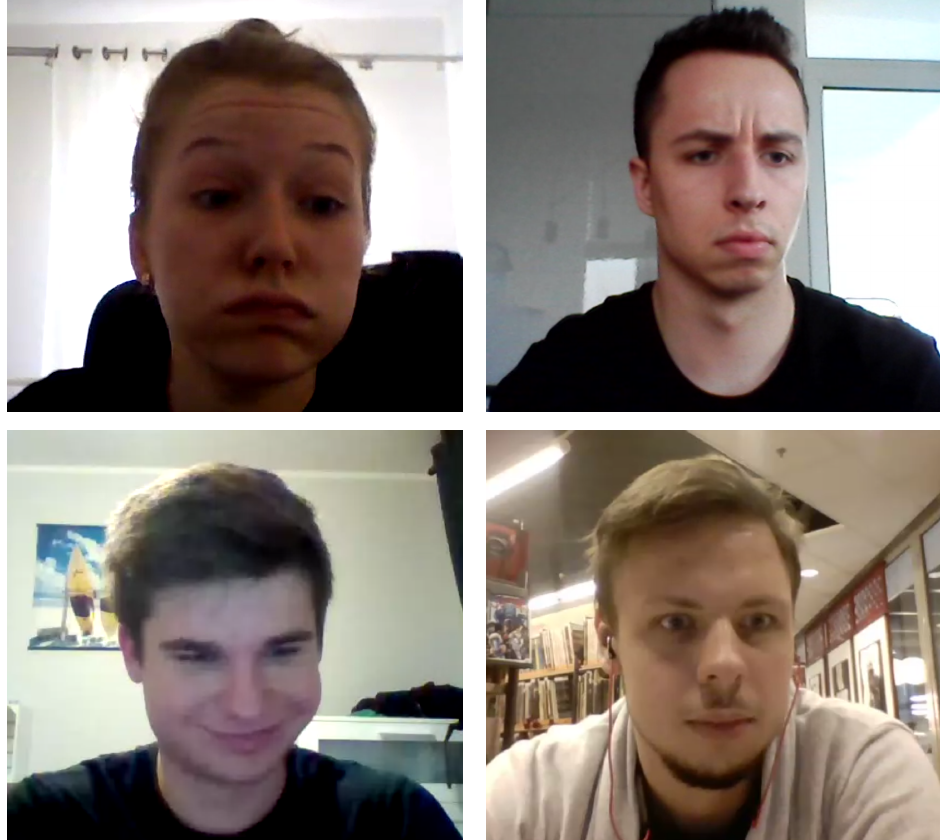
Figure 1. Sample frames from DevEmo dataset video clips.